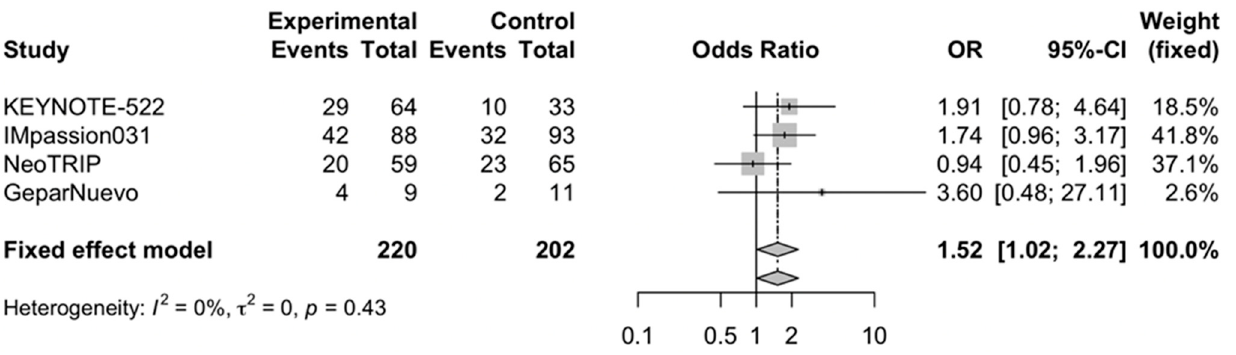
Figure 5. Forest plot of comparison between neoadjuvant chemoimmunotherapy versus chemother-